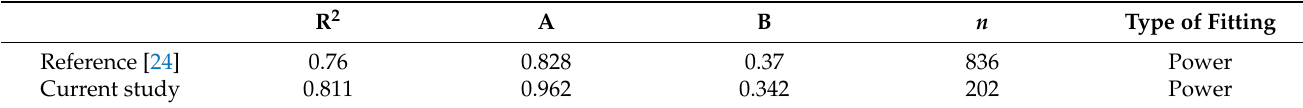
Figure 4. Span as a function of GTOW for the general sample category. Table 3. Reference dataset trend factor results and comparison of the corresponding literature [24].